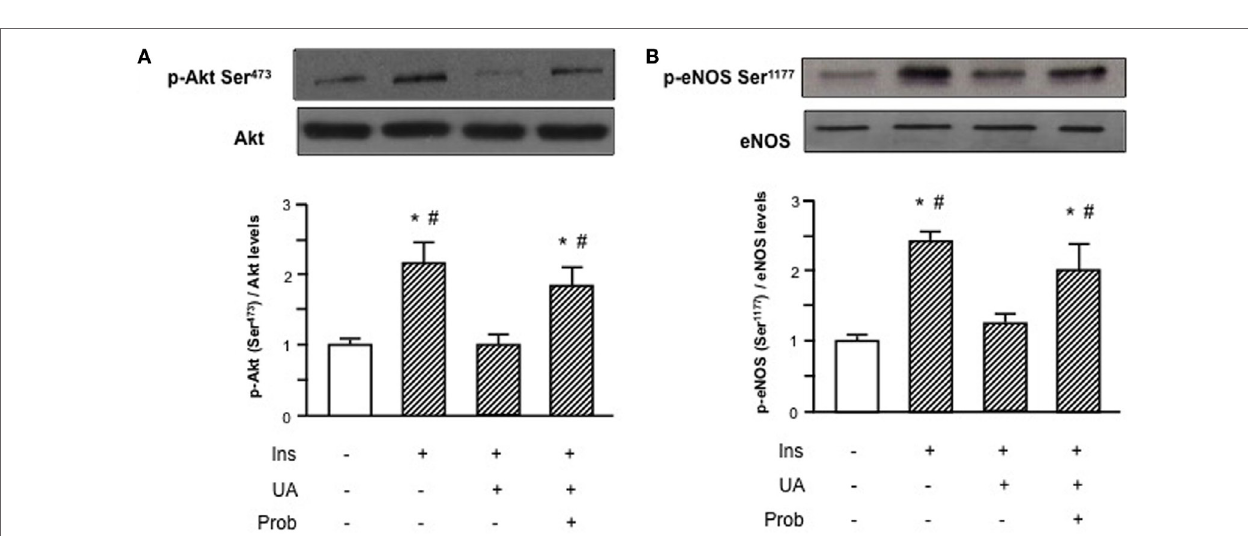
FigUre 3 | Effects of the SLC22A12 (URAT1) inhibitor Probenecid on uric acid (UA)-mediated effects on insulin downstream signaling in human umbilical vein endothelial cells (HUVECs). Exposure of HUVECs to Probenecid (1 mM, 30 ′ ) restores Akt (a) and endothelial nitric oxide synthase (eNOS) (B) insulin-induced phosphorylation levels in presence of UA. To normalize the blots for protein levels, after being immunoblotted with anti-phosphospecific antibodies, the blots were stripped and reprobed with anti-Akt or anti-eNOS total levels. Each bar represents the mean ± SD of three independent experiments and autoradiographs of a representative experiment are shown. * P < 0.05 vs basal value; # P < 0.05 vs insulin + UA.